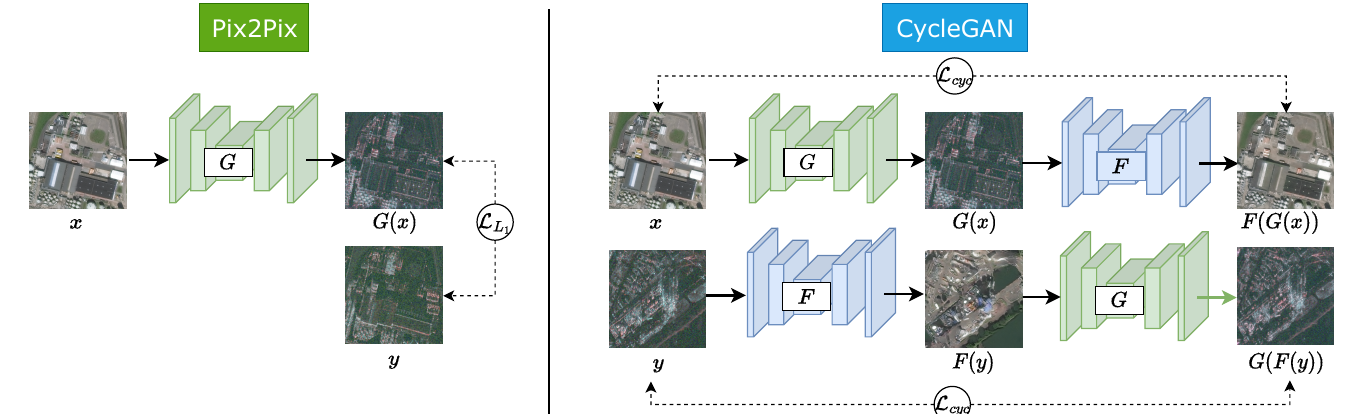
Figure 2. Comparisons between Pix2Pix and CycleGAN. Discriminators are omitted for